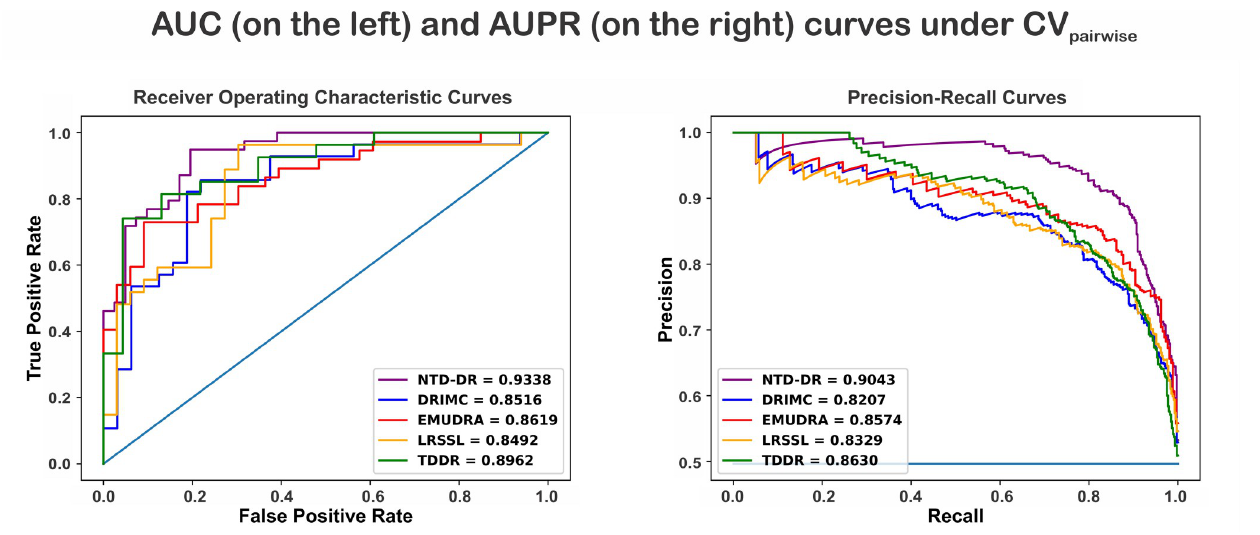
Fig 3. ROC and precision-recall curves of NTD-DR and the existing methods for Scenario CV pairwise using dataset P.